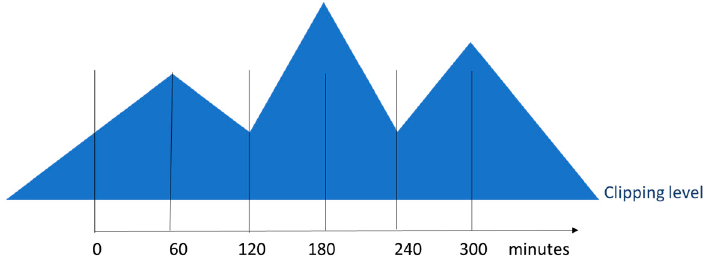
Figure 4. A ridge: Subsequent peaks in a time series regime with hourly measurement. With high resolution metering, the area can be found as a function of the ridge’s ex- tension above the base line and the required period of curtailment.